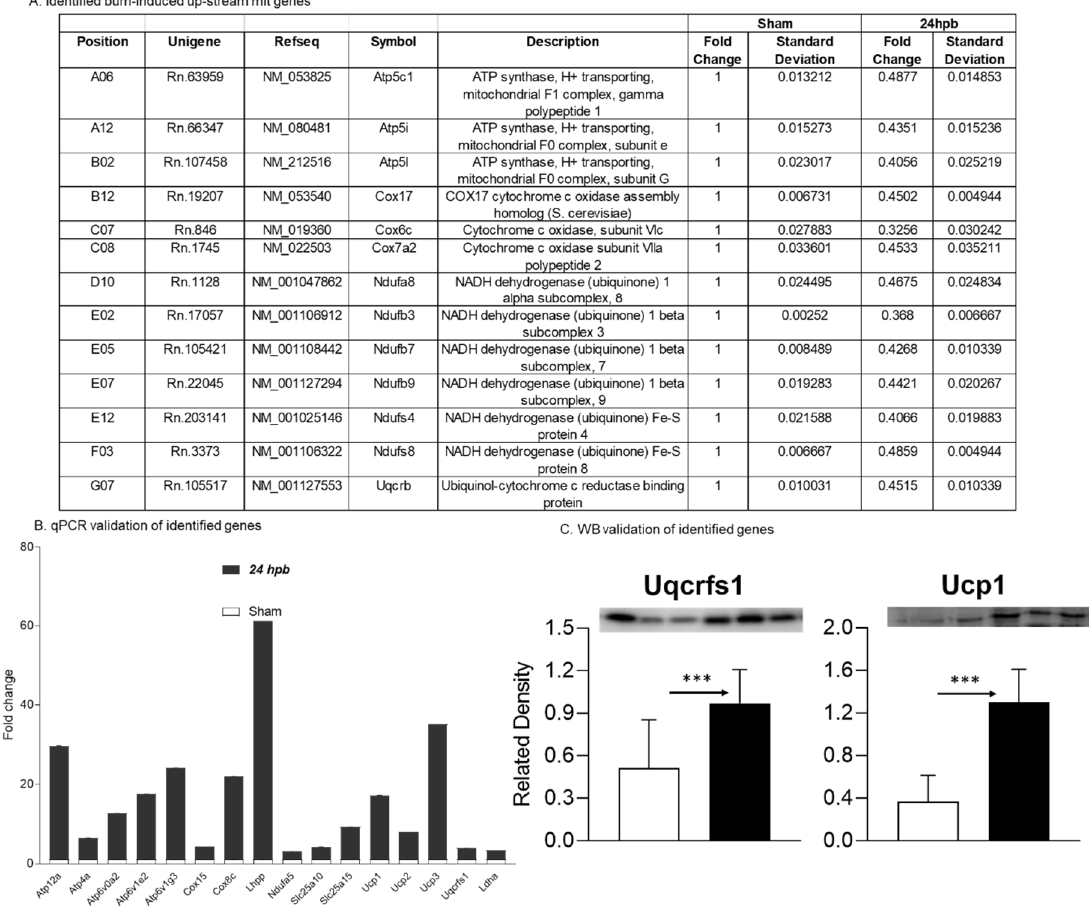
Figure 6. Upregulated cardiac metabolism-related genes after burn: ( A ) names, locations, fold change, p -values, and NCBI gene IDs of identified genes; ( B ) data validation of identified downregulated genes with qPCR and Western blotting ( C ). *** p < 0.001 (Sham vs. 24 hpb).